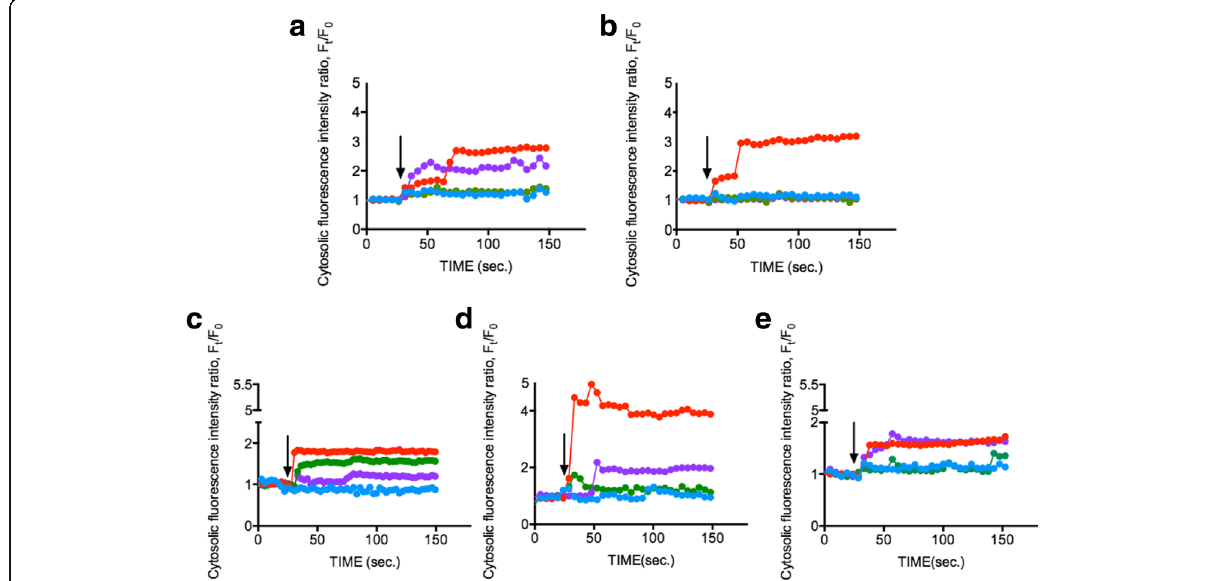
Fig. 2 Measurement of intracellular Ca 2+ concentration after stimulation by different ENPs. Different phytoplankton cells a Dunaliella tertiolecta , b Thalassiosira pseudonana , c Skeletonema grathae , d Phaeodactylum tricornutum , and e Odontella mobiliensis were treated with TiO 2 25 nm (green), SiO 2 10 – 20 nm (red), CeO 2 15 – 30 nm (purple) with a concentration of 1 mg/ml and control (blue). Black arrow indicates the time point when EPNs were applied (30 s). The measurements show representative data from an average of 20 individual